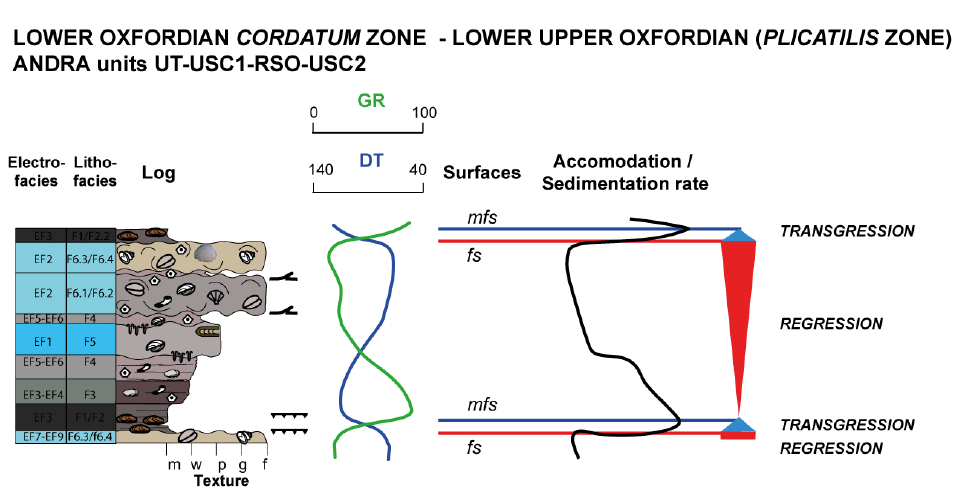
Figure 7. Scheme of typical high-frequency sequences (lithofacies, electrofacies, GR, DT) in the uppermost Lower Oxfordian / lowermost Middle Oxfordian deposits.